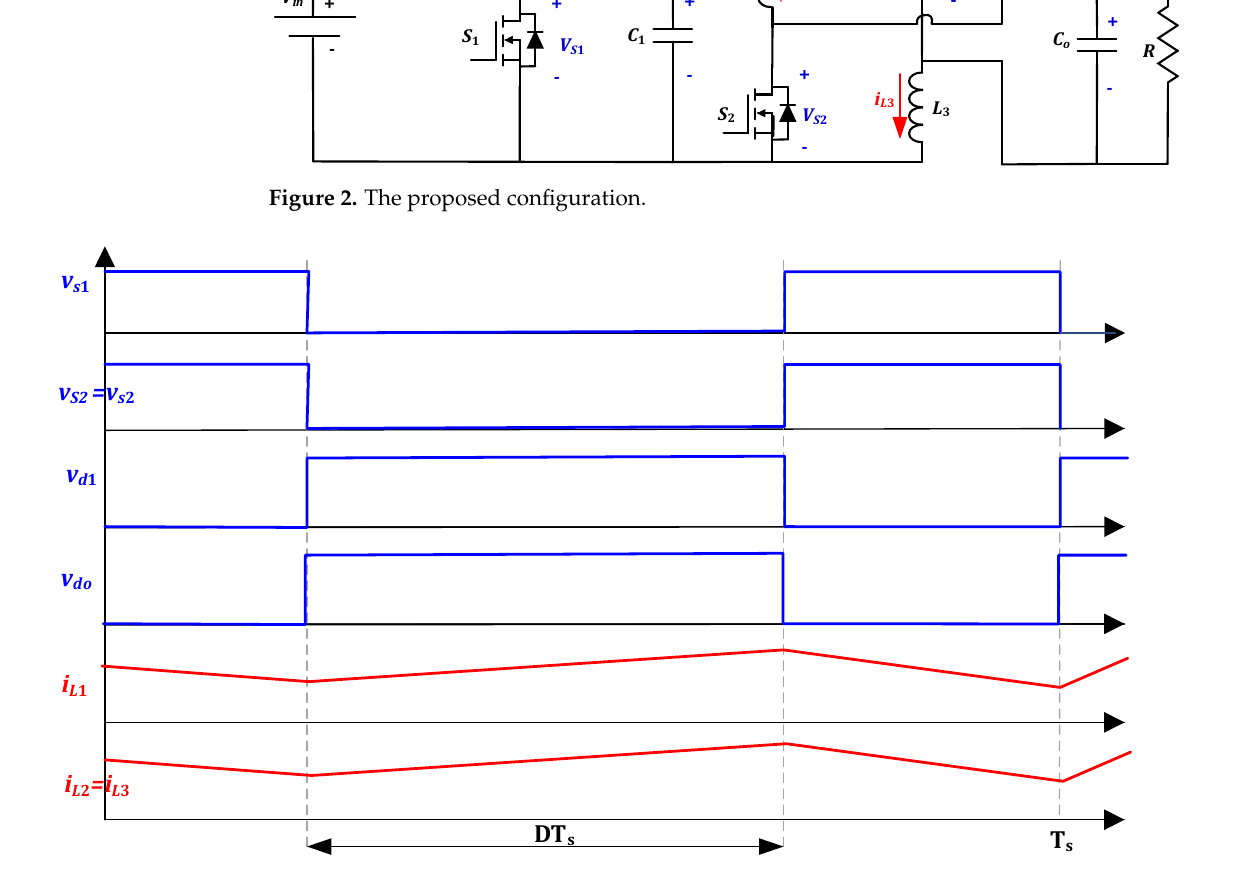
Figure 4. The configuration of mode I.